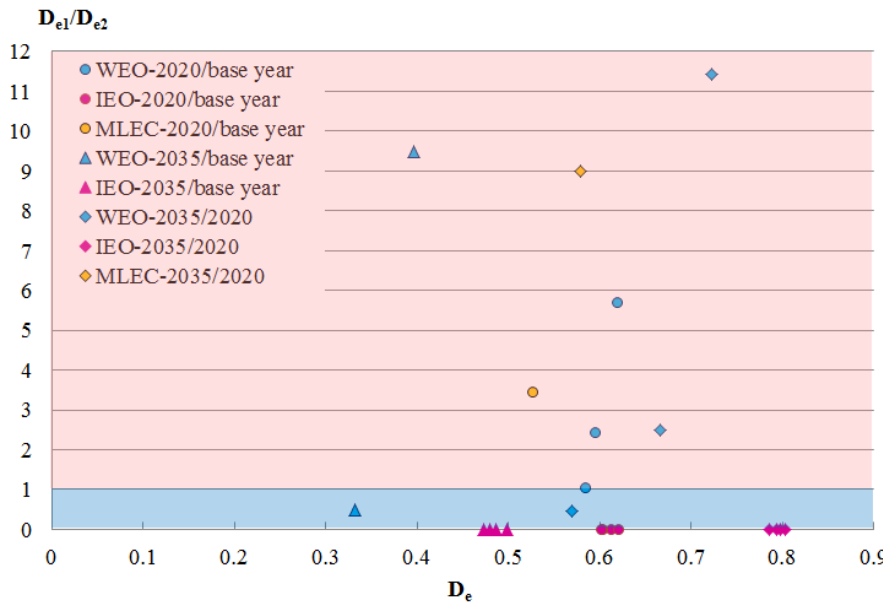
Figure 13. Index decomposition of energy intensity.